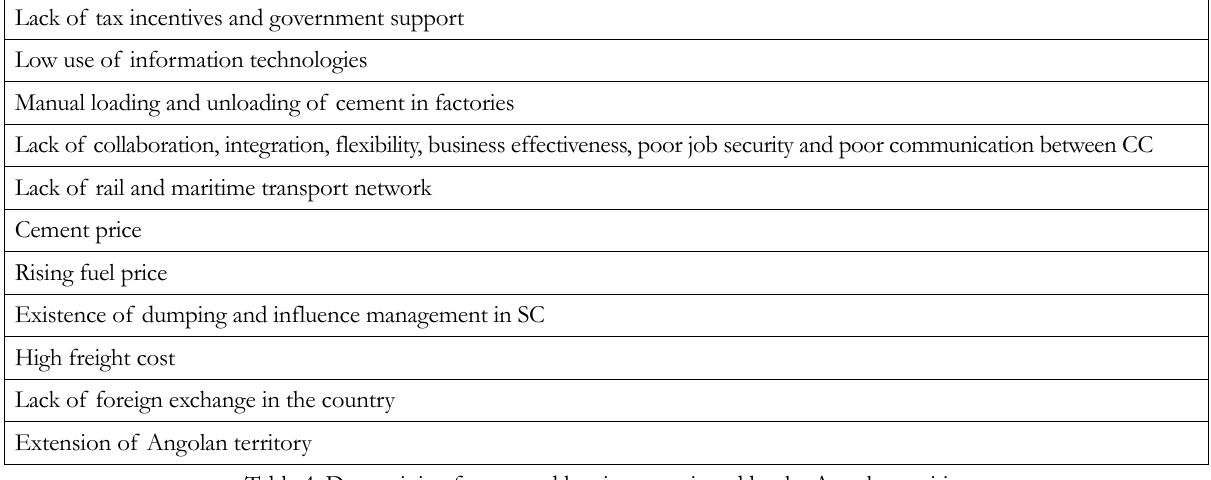
Table 4. Determining factors and barriers mentioned by the Angolan